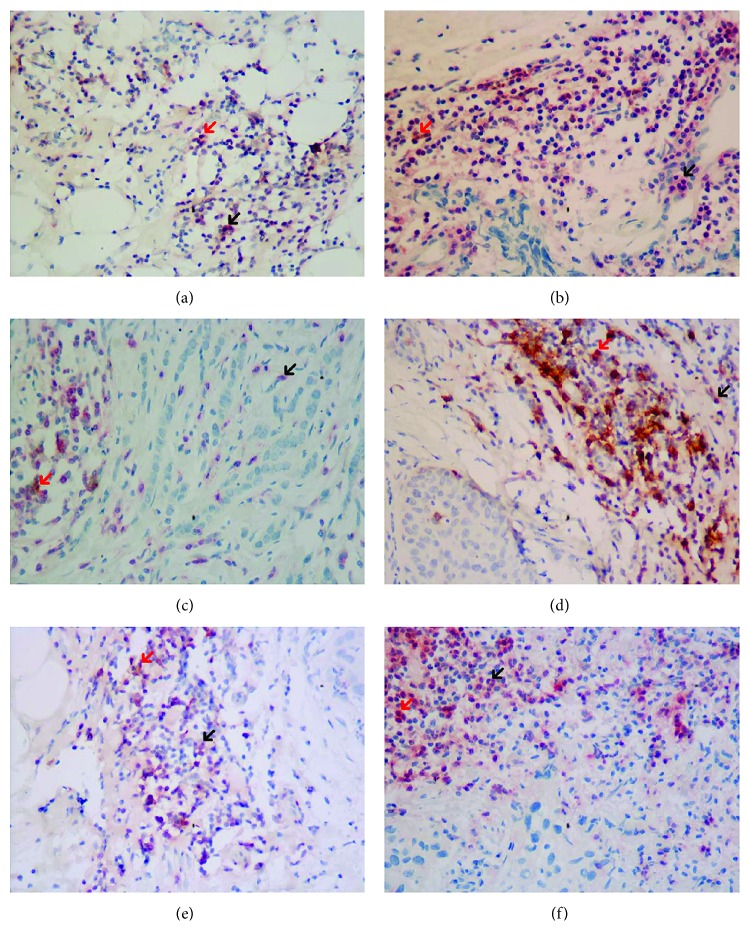
Expression of E-Cad, Ki-67, CK20, and counts of phenotypes of CD4/PD-1 TILs. (a) Patients with negative E-Cad expression (IHC, ×400). (b) Patients with positive E-Cad expression (IHC, ×400). (c) Patients with negative Ki-67 expression (IHC, ×400). (d) Patients with positive Ki-67 expression (IHC, ×400). (e) Patients with negative CK20 expression (IHC, ×400). (f) Patients with positive CK20 expression (IHC, ×400). →CD4+/PD-1+ TILs; →CD4+/PD-1− TILs. CD4+/PD1+ TILs showed red cytomembrane and brown cytoplasm, and CD4+/PD1− TILs showed red cytomembrane. Patients with negative E-Cad had less CD4+/PD-1− TILs than those with positive E-Cad; patients with negative Ki-67 had less CD4+/PD-1+ TILs than those with positive Ki-67; patients with negative CK20 expression had less CD4+/PD-1− TILs than those with positive CK20 expression.